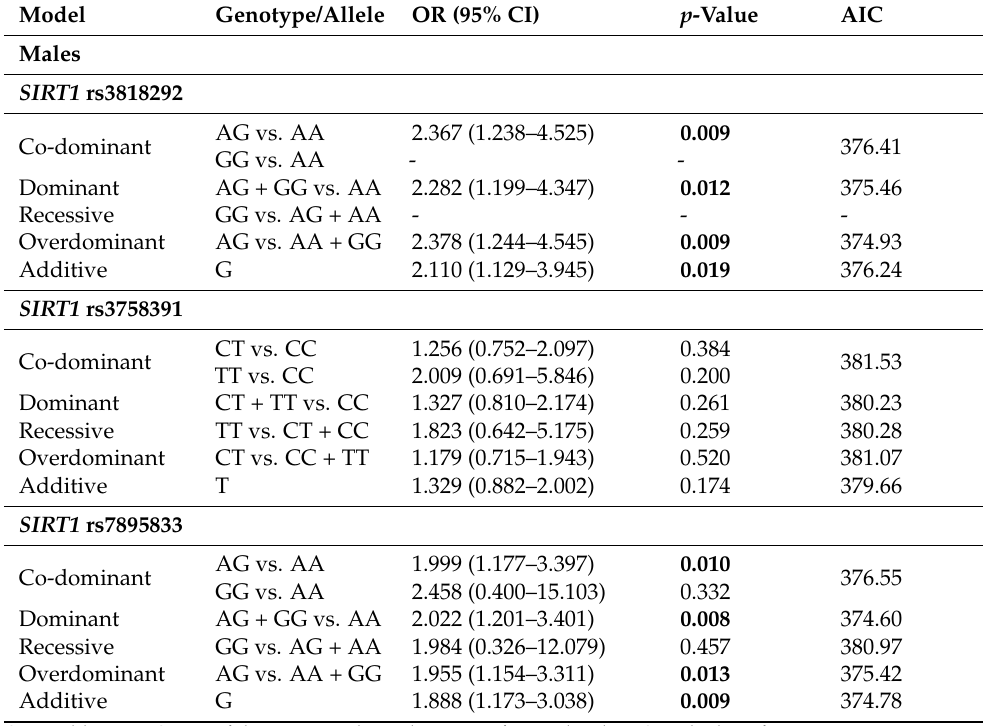
Table 6. Genotype and allele distribution of SIRT1 rs3818292, rs3758391, and rs7895833 in periodonti- tis and control groups within